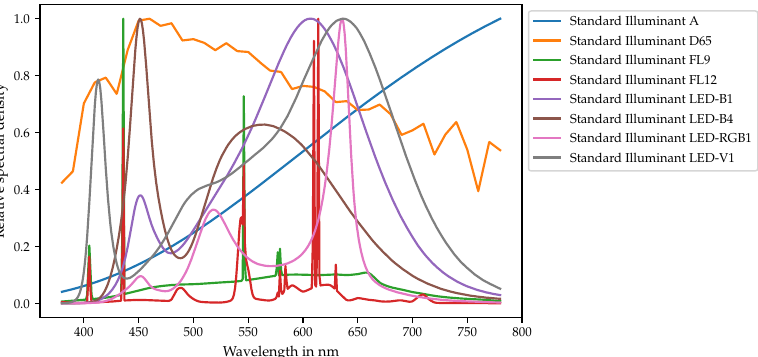
Figure 4. Test spectra “T” for evaluating the differences in the signals of sensors of the same type on identical illumination